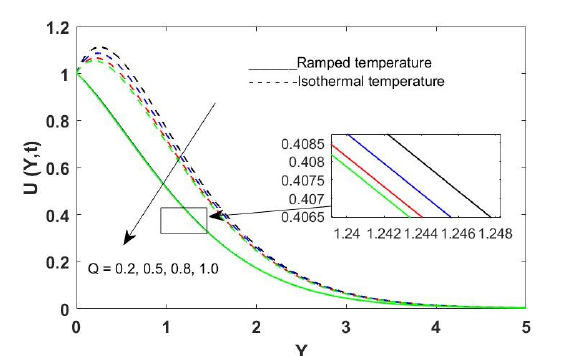
Figure 3: Momentum distribution versus Q t =0.3, R=0.2, E=1, S=1, K=1, kp=1.5, , Ω = 30 0 , ψ = 0.5 , Pr =0.71, Sc =0.60, Gr=3,